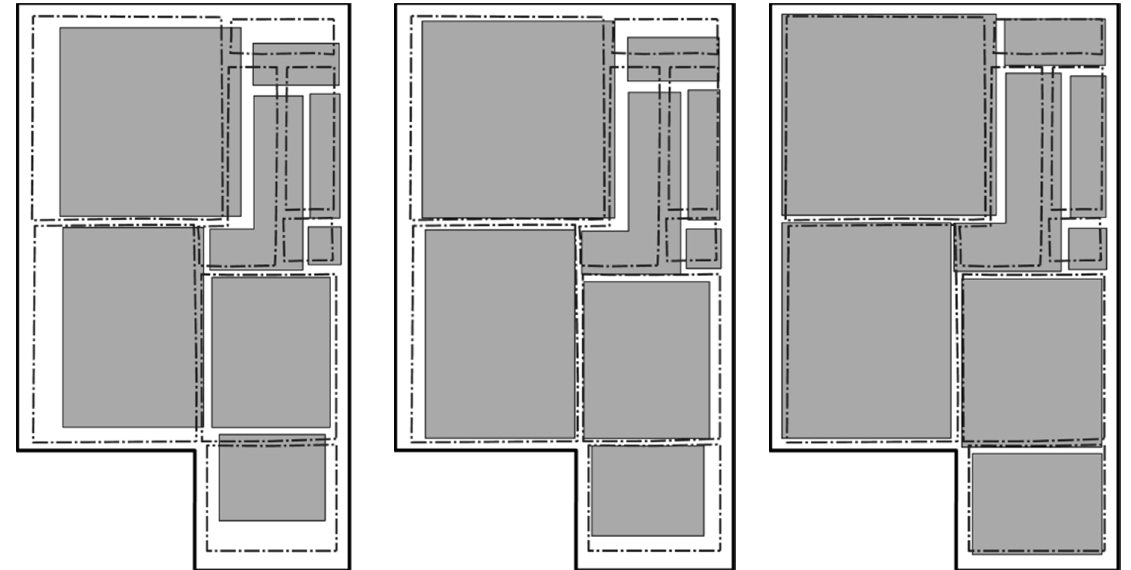
Figure 5. Input plan ( left ), gradient-descent ( centre ) and proposed method results for plan A ( right ). Plan measurements (solid grey), ground-truth (dashed